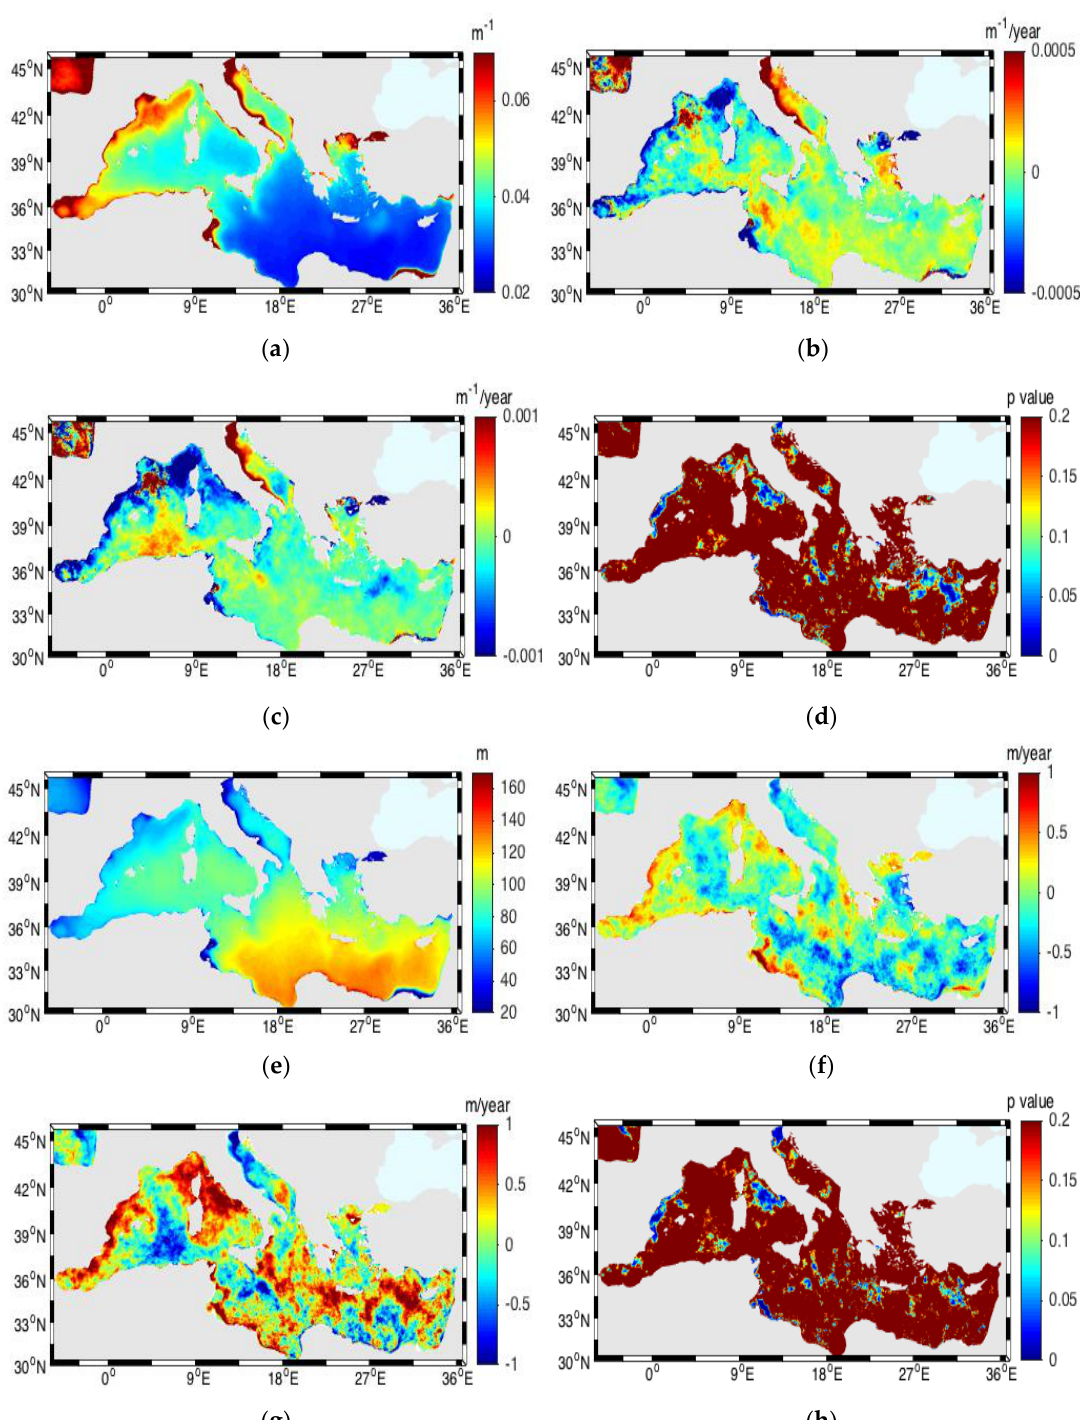
Figure 11. ( a ) Mean (2003–2017) vertical diffuse attenuation coefficient K d (490) based on MODIS Aqua data; ( b ) trends in annually averaged K d (490); ( c ) trends in spring (March–May) averaged K d (490); ( d ) p -values for trends shown in figure ( c ); ( e ) mean (2003–2017) euphotic depth, Z eu , based on MODIS Aqua data; ( f ) trends in annually averaged Z eu ; ( g ) trends in spring (March–May) averaged Z eu ; ( h ) p -values for trends shown in ( e ).